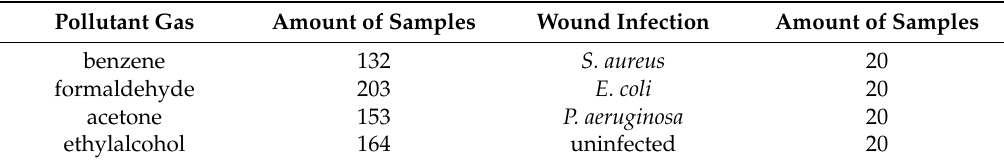
Table 4. Amount of samples.